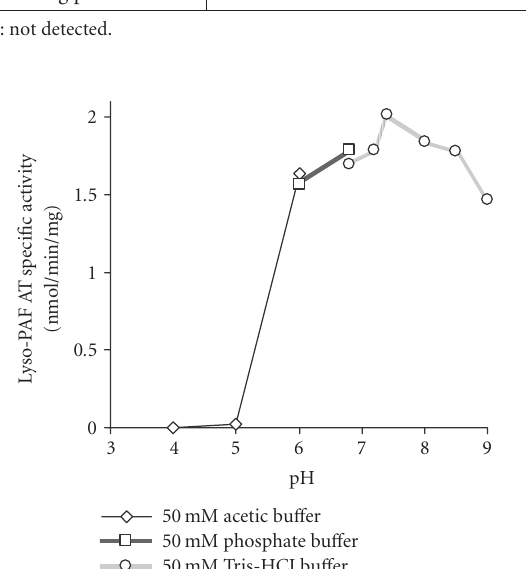
Figure 1. E ff ect of pH on lyso-PAF AT specific activity of mesan- gial cells: TM fractions of HMC 0 . 23mg/mL were incubated in the presence of di ff erent bu ff er solutions. Results are the aver- age of two independent determinations using di ff erent enzyme preparations performing duplicate samples.